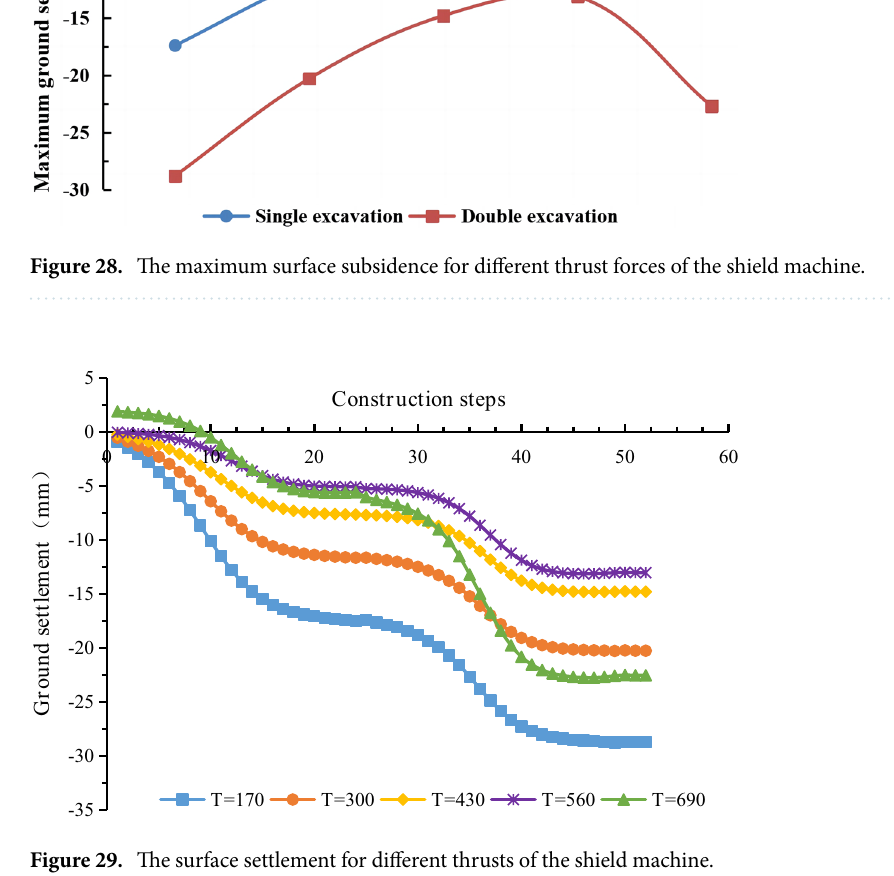
Figure 29. The surface settlement for different thrusts of the shield machine.